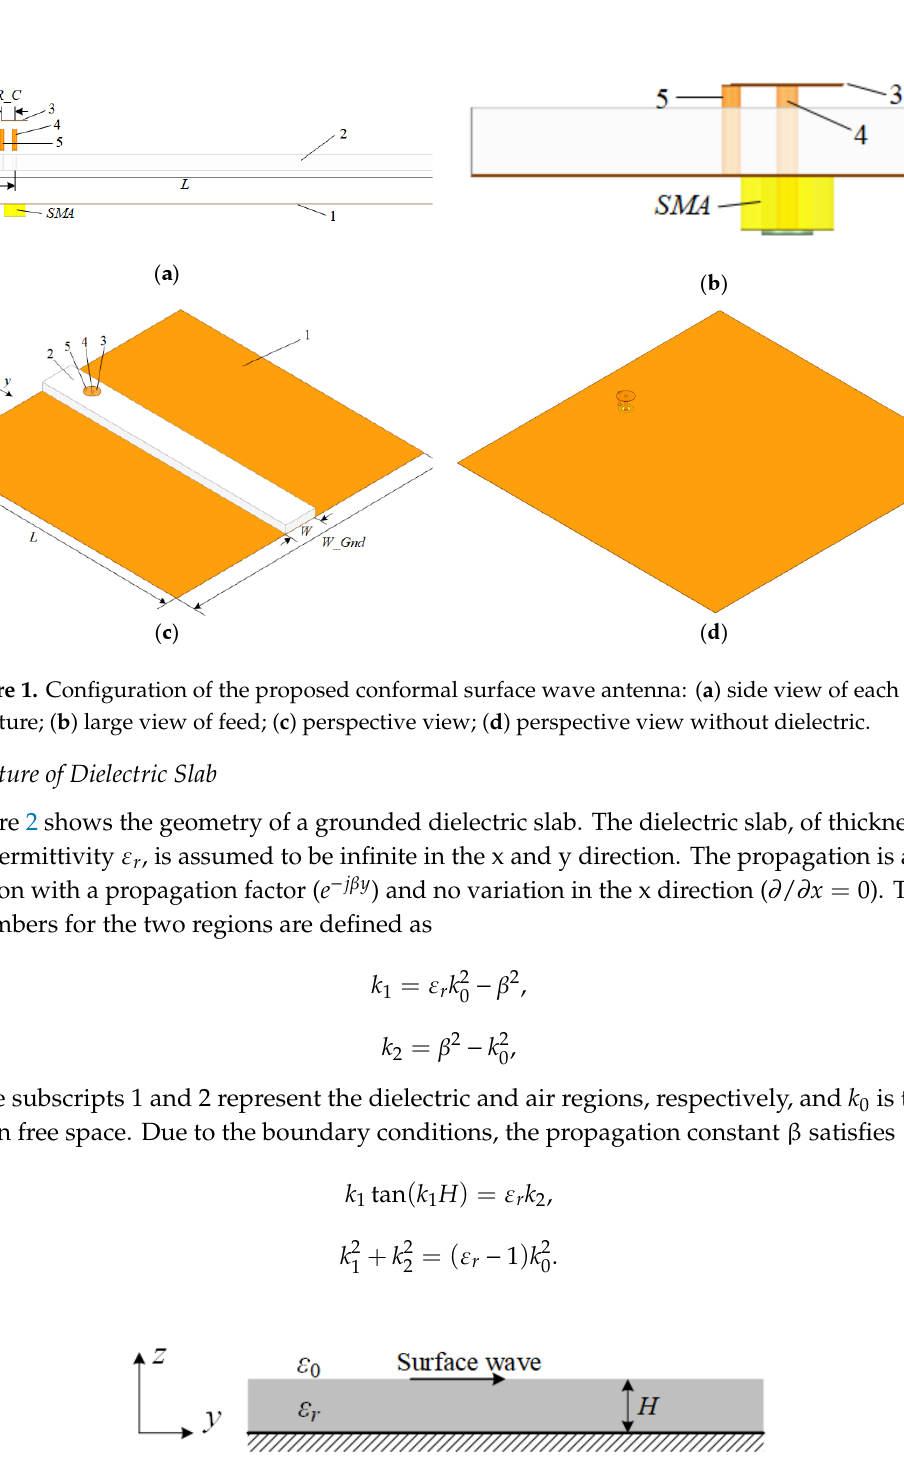
Figure 2. Geometry of a grounded dielectric slab.